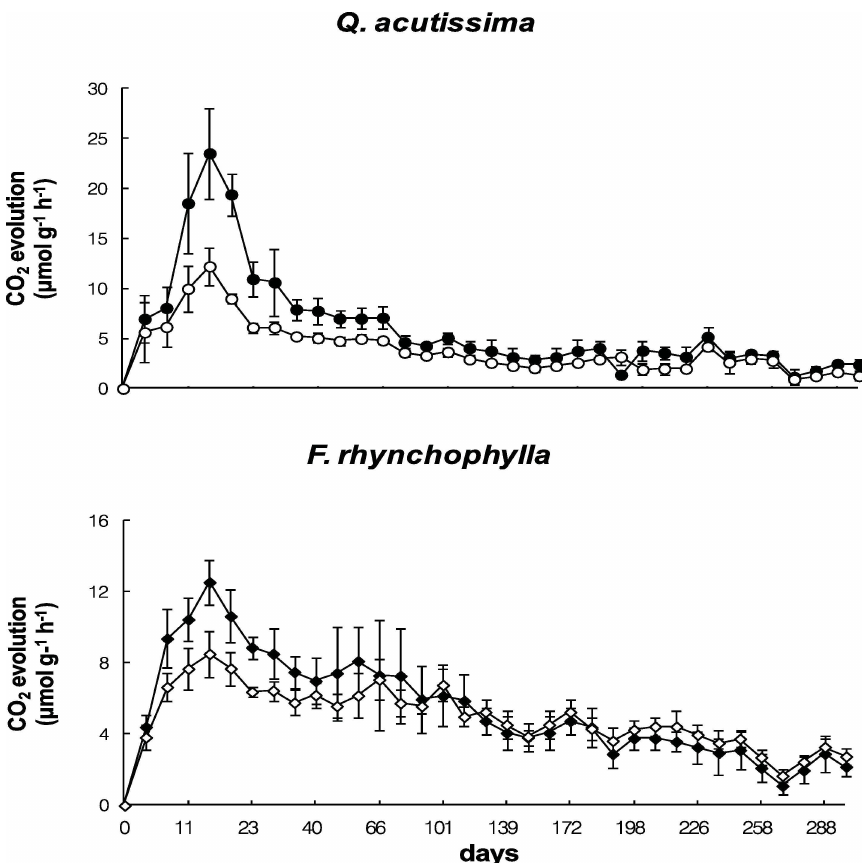
Fig 4. Changes in CO 2 evolution from the decomposing leaf litter in the microcosms. Closedcircles representleaf litter obtainedfrom the ambient air (380 ppm CO 2 ) chamber, and open circles represent leaf litter obtained from the elevatedCO 2 (700 ppm) chamber. Bars show standard deviations (n = 4).